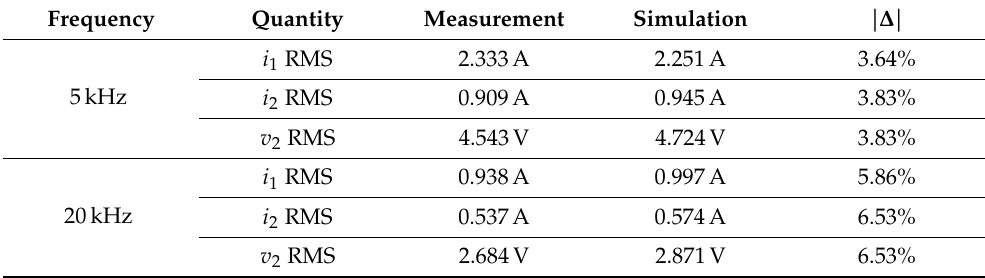
Table 3. Measured vs. simulated RMS values for currents and voltages. Simulations were carried out in Simulink ® , see Figures 13 and